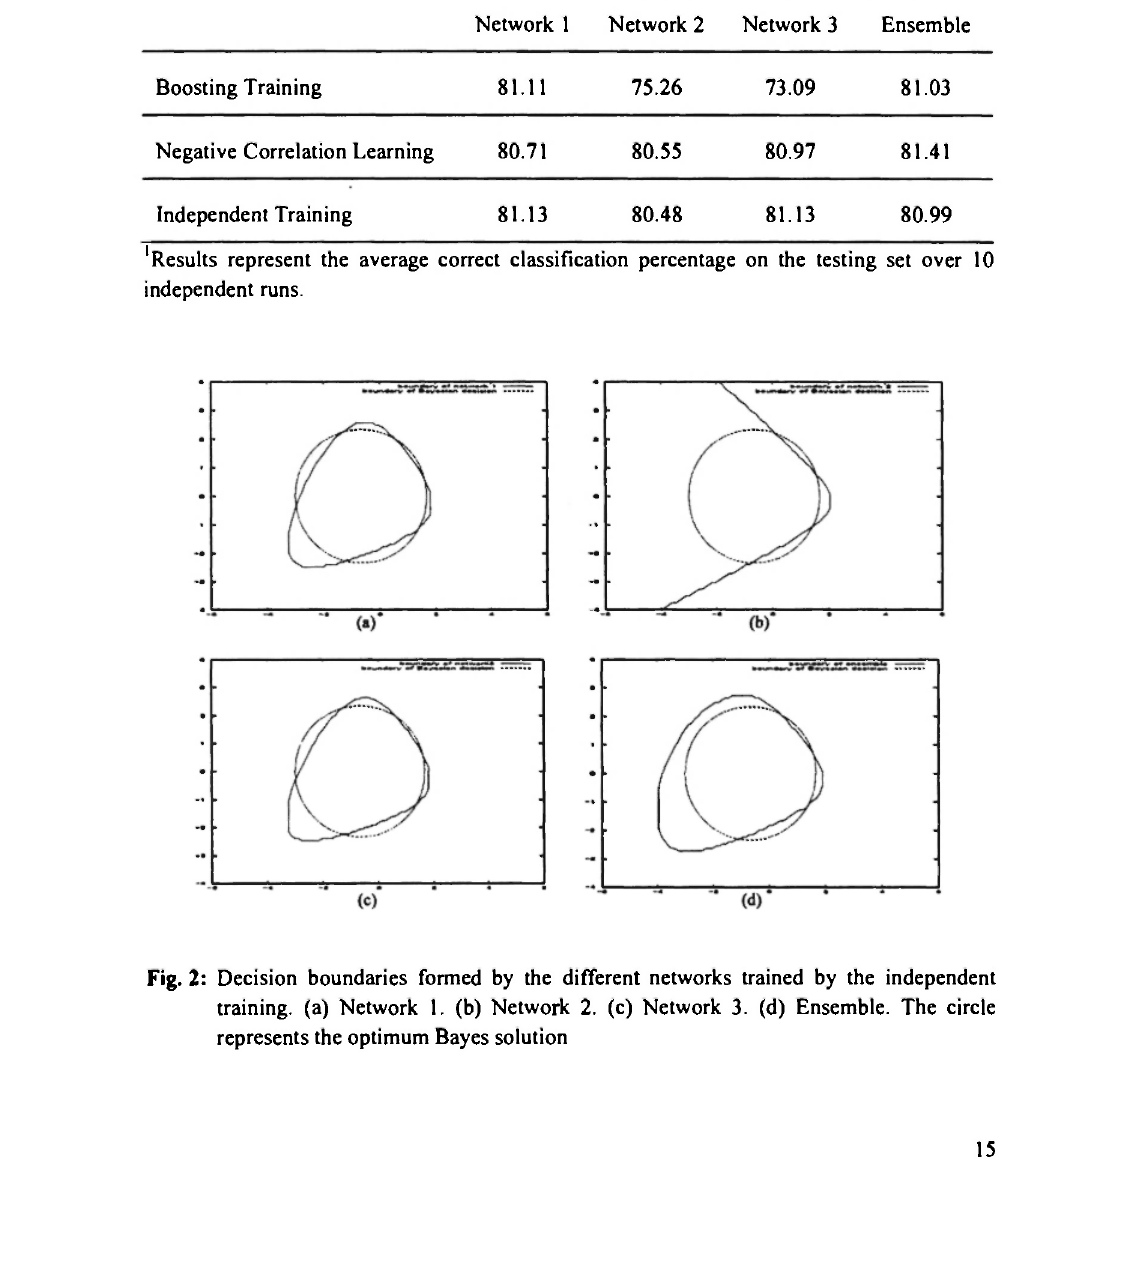
Fig. 2: Decision boundaries formed by the different networks trained by the independent training, (a) Network 1. (b) Network 2. (c) Network 3. (d) Ensemble. The circle represents the optimum Bayes